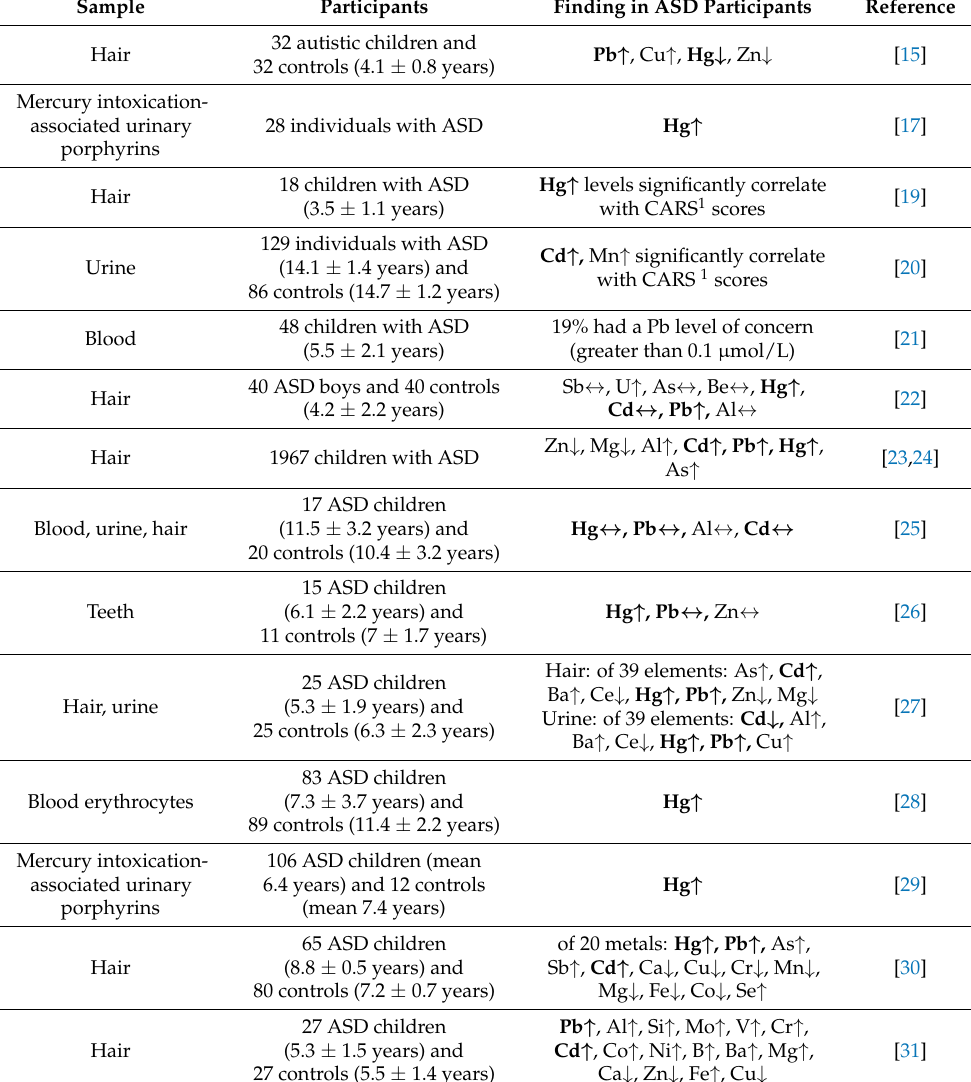
Table 1. Overview of examples of epidemiological studies investigating the association of toxic metals with ASD. The toxic metals discussed in this review are highlighted. Systematic reviews and meta-analyses are